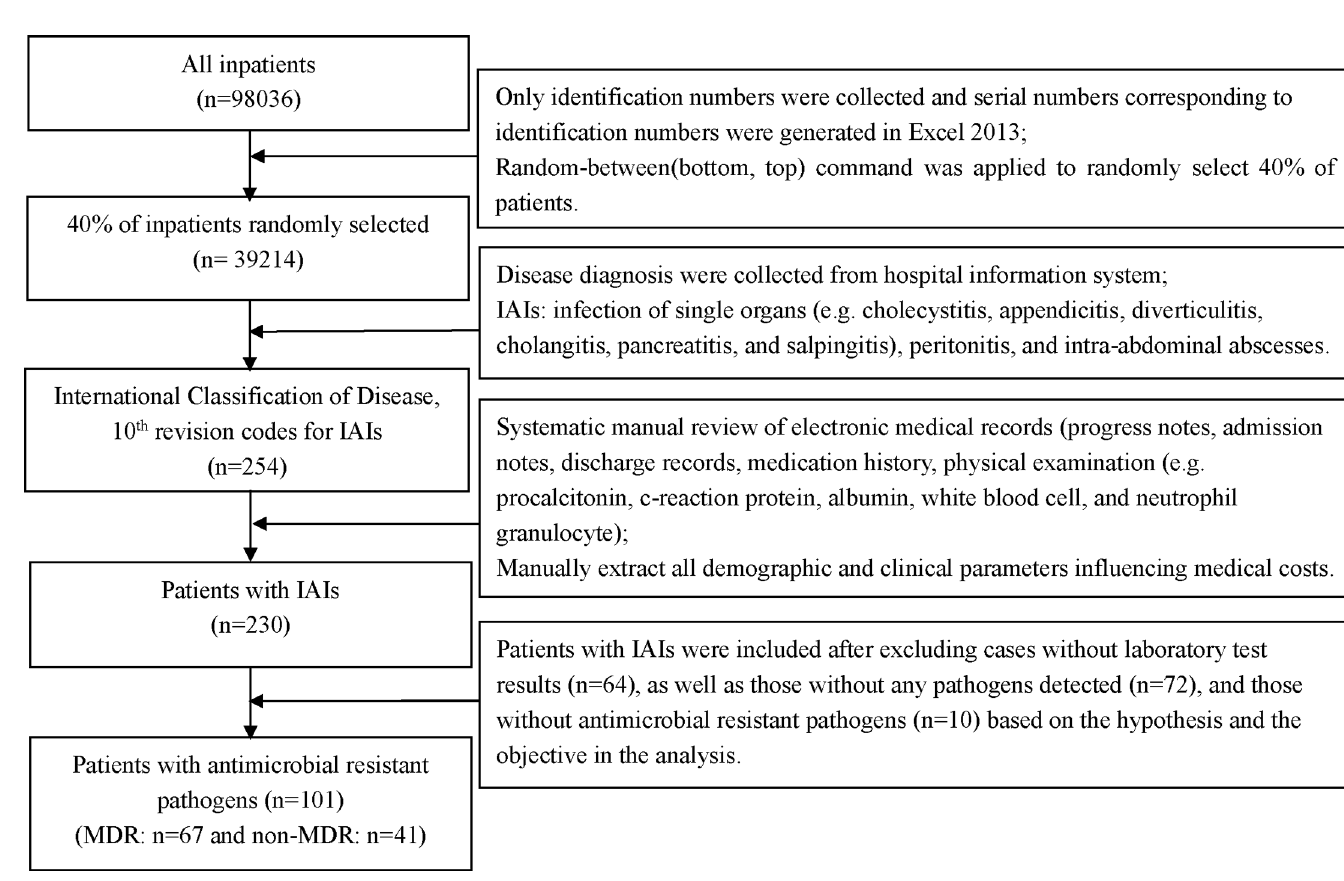
Fig 1. Sample collection